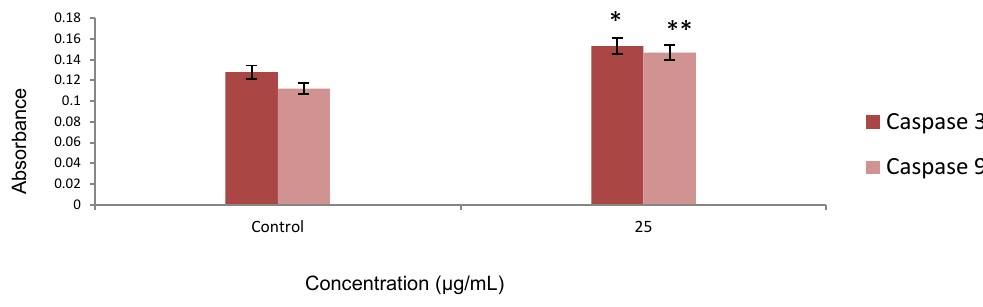
Figure 9. The activity of caspase-3 and caspase-9 was increased after 24 h treatment, which indicates significant apoptosis * p < 0.05, ** p < 0.001, Data are presented as mean ±